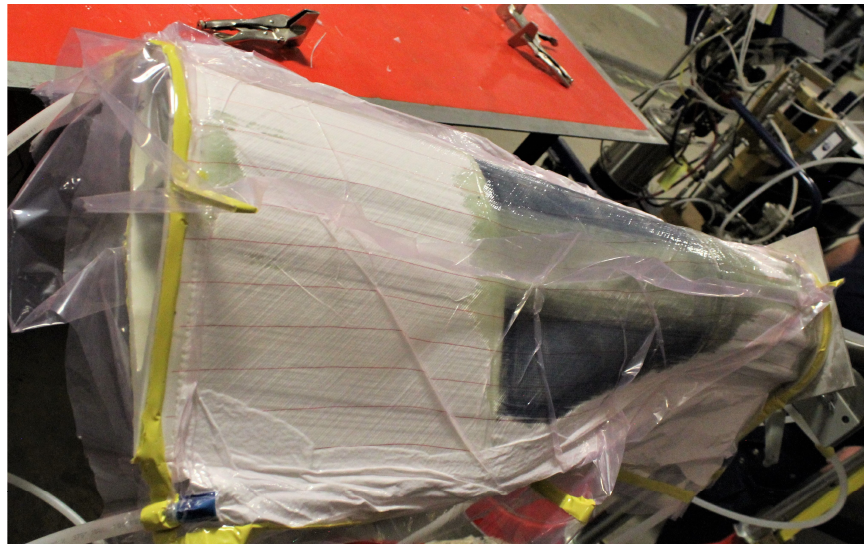
Figure 8. Photo taken mid-infusion, showing the epoxy resin saturating the fiberglass around the transition section and beginning to flow through the root and main foil sections.